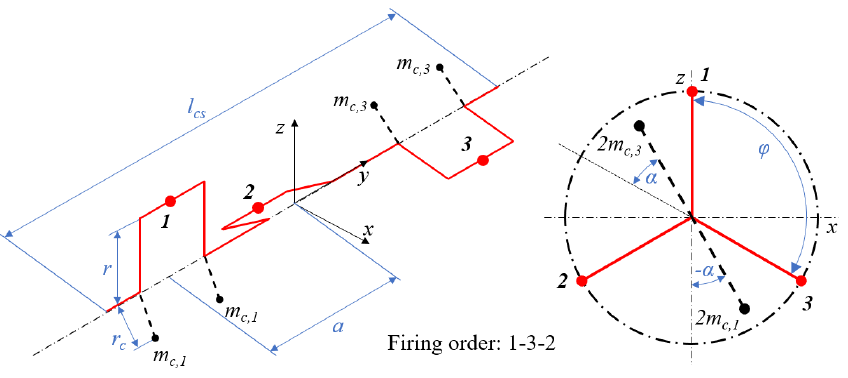
Figure 1. Model of the crankshaft for a 3 cylinder in-line engine, with the relative polar plot on the